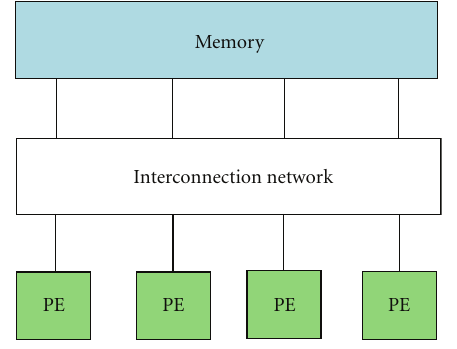
Figure 2: Heterogeneous multiprocessor systems.